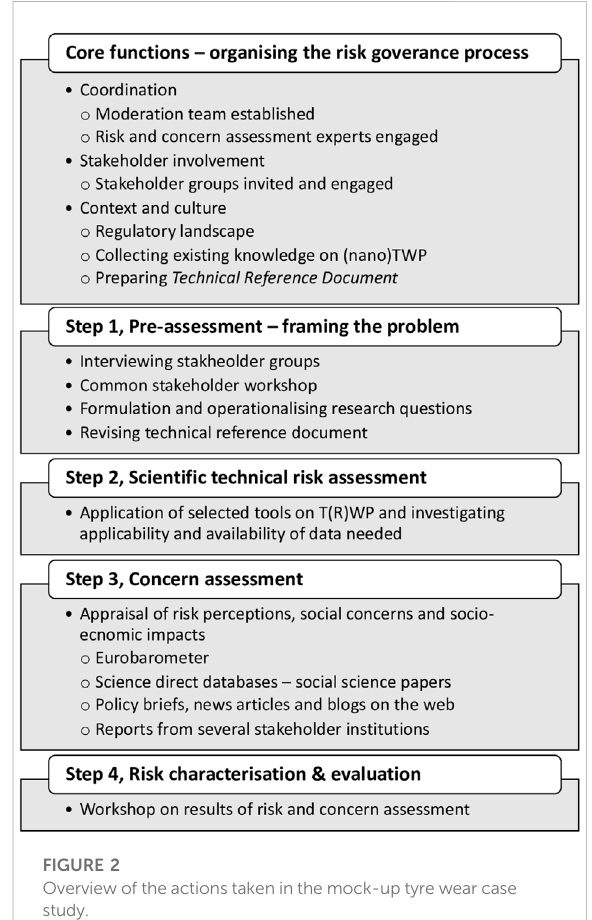
FIGURE 2 Overview of the actions taken in the mock-up tyre wear case